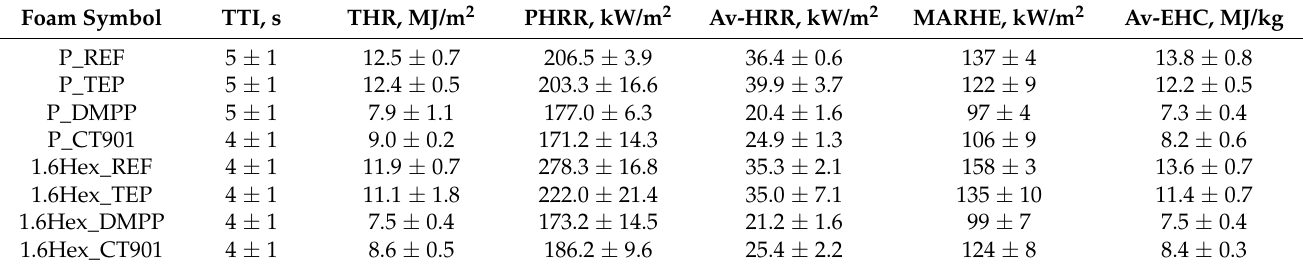
Table 6. The results of cone calorimeter tests.